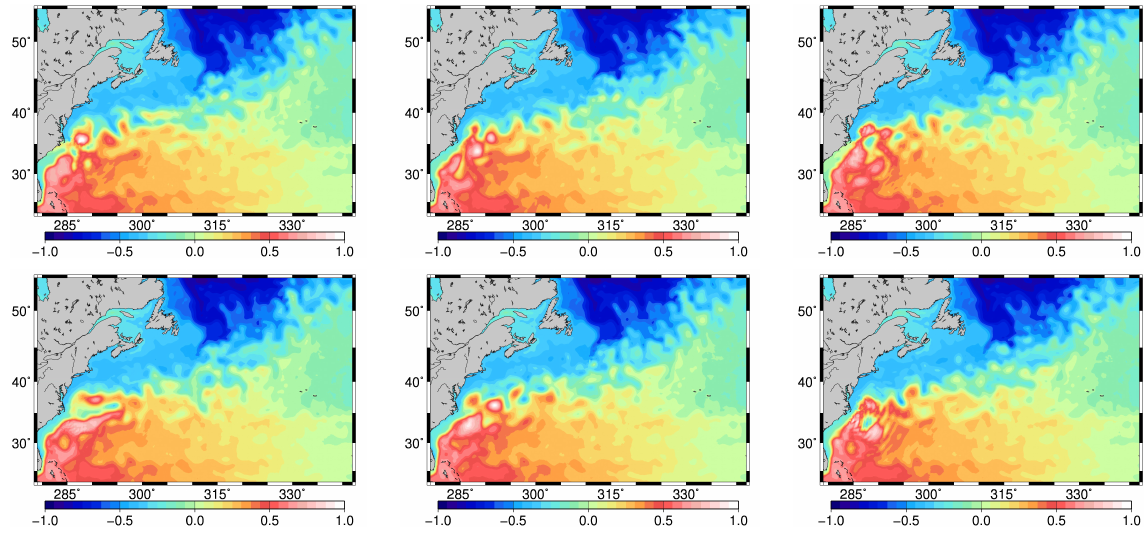
Figure 1. Six members from the free-run 96-member ensemble SSH (in m); snapshots for 9 July 2005.